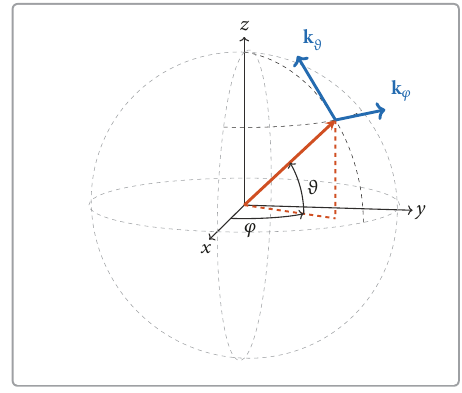
Figure 1: Spherical coordinate system and angle